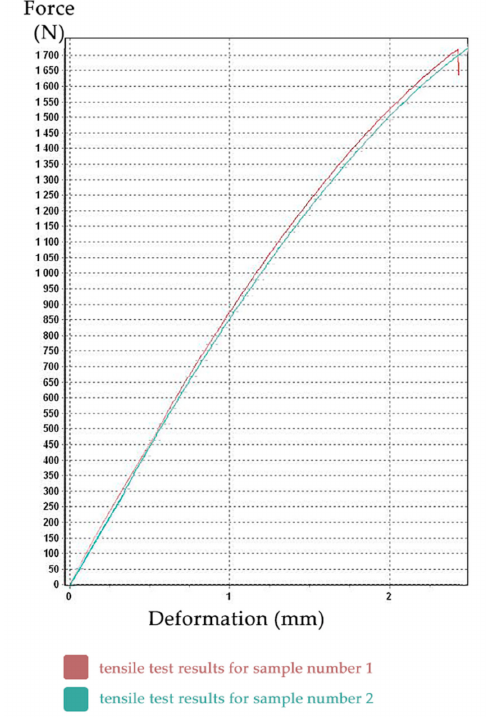
Figure 9. Tensile diagram of sample No.1. (red) and No. 2 (aquamarine).